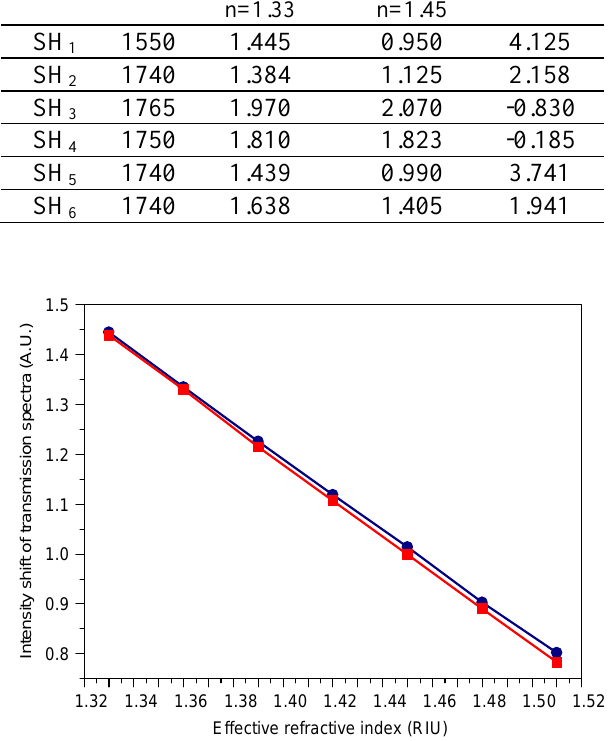
Fig.5. Normalized curve of the intensity of resonant wavelength with respect to the effective refractive index in sensing hole. Curves marked by closed circle and closed square represent normalized curves of SH SH , 5